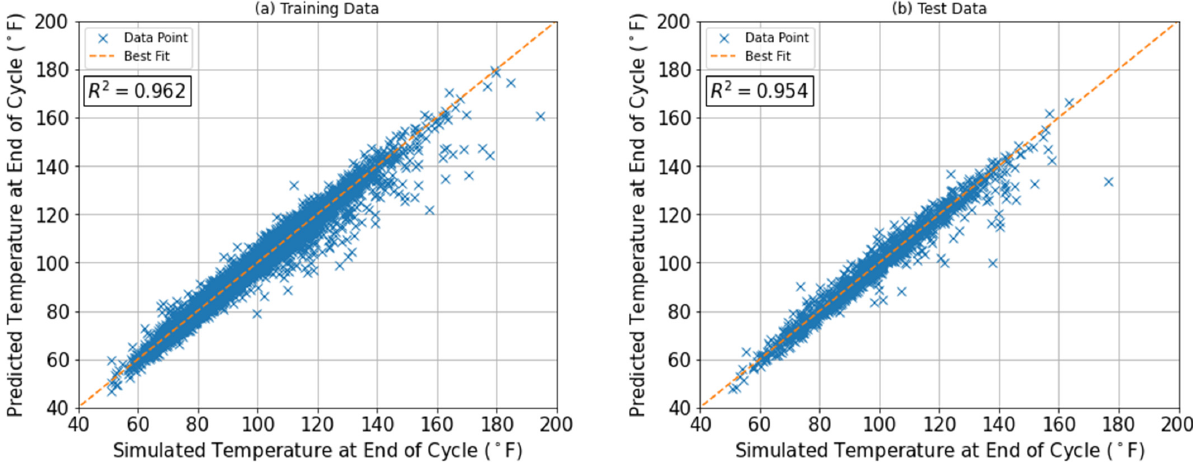
Figure 13. Predicted and simulated plot of ( a ) training data and ( b ) testing data for reservoir temperature at the end of the cycle—polynomial regression model.